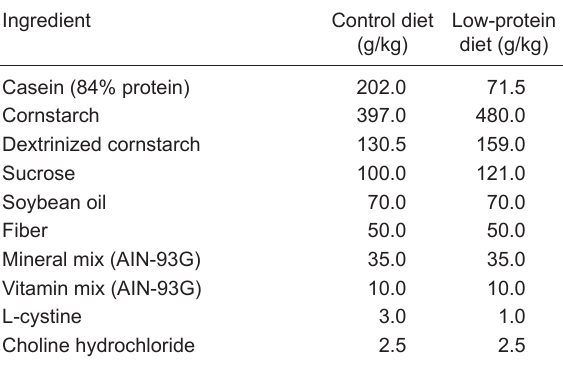
Table 1. Composition of the control (17% protein) and low-protein (6% protein) isocaloric